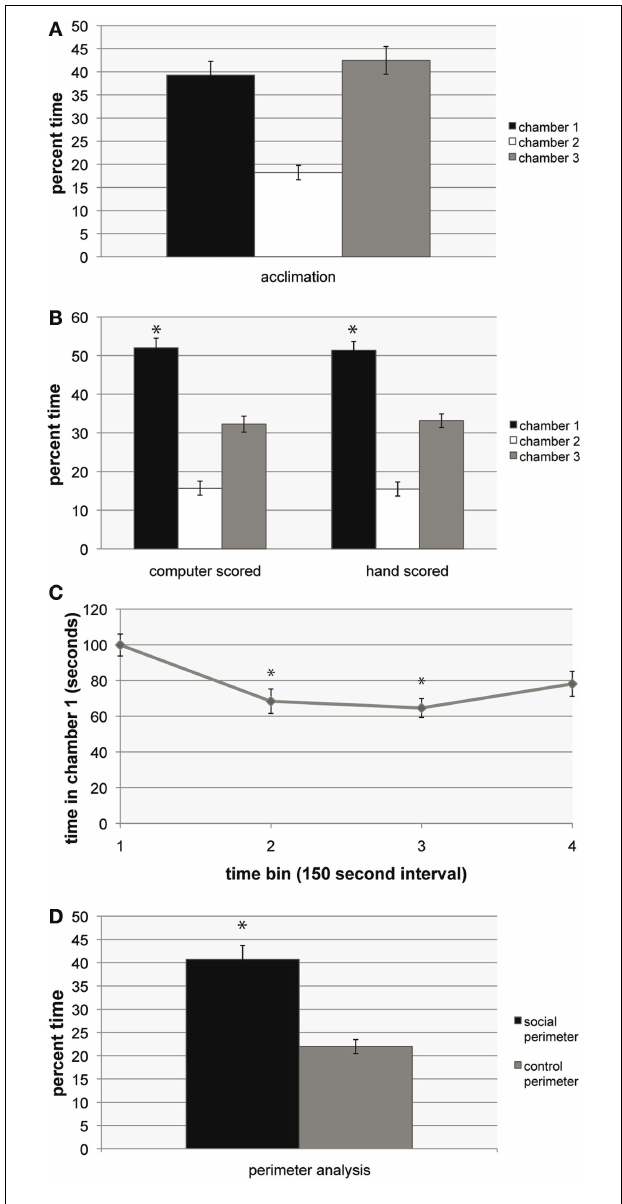
FIGURE 3 | Social approach data. (A) Data showing social approach behavior. All trials use male C57BL/6 mice, tested at 8 weeks of age. For (A–C) , n = 12, for (D) , n = 10. Error bars indicate SEM. (A) Percent time spent in chambers 1, 2, and 3 during 5-min acclimation. (B) Comparison of computer-assisted scoring and experimenter scoring of 10-min social approach trials with stimulus mouse in chamber 1. Signifi cant preference